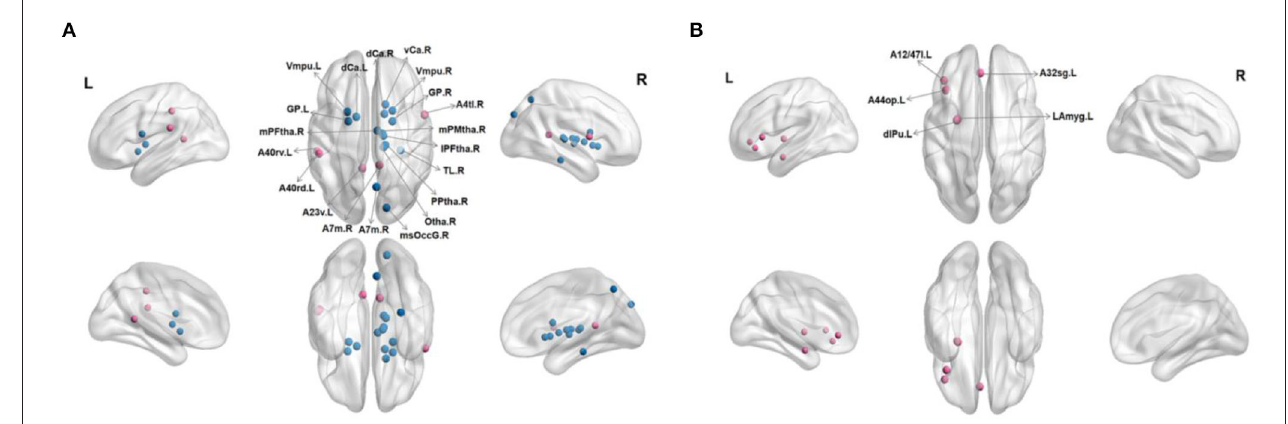
FIGURE 3 | Regions with significant differences in nodal efficiency between patients with RC and HC. Nonparametric permutation tests were applied to nodal efficiency of all 246 cortical regions ( p < 0.05; 5,000 permutation test, FDR correction). (A) Represented FN, and (B) represented SN. Red is for increased nodal efficiency in RC patients group, while blue is for decreased nodal efficiency in RC patients group. L, left; R,